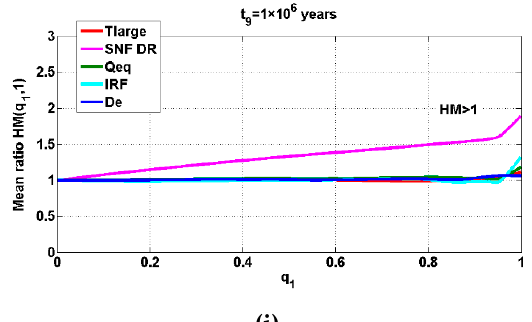
Figure 12. Ratio of the mean (smoothed by the regression technique) due to the increased lower bound of the range of parameters (Tlarge, SNF DR, Qeq, IRF, De) for di ff erent time points: ( a ) at 1 × 10 3 years after repository closure; ( b ) at 5 × 10 3 years after repository closure; ( c ) at 1 × 10 4 years after repository closure; ( d ) at 2 × 10 4 years after repository closure; ( e ) at 5 × 10 4 years after repository closure; ( f ) at 1 × 10 5 years after repository closure; ( g ) at 2 × 10 5 years after repository closure; ( h ) at 5 × 10 5 years after repository closure; ( i ) at 1 × 10 6 years after repository closure (Tlarge—defect size enlargement time, SNF DR—SNF matrix dissolution rate, Qeq—equivalent groundwater flow rate around the canister, IRF—instant release fraction, De—e ff ective di ff usivity of I-129 in bentonite).